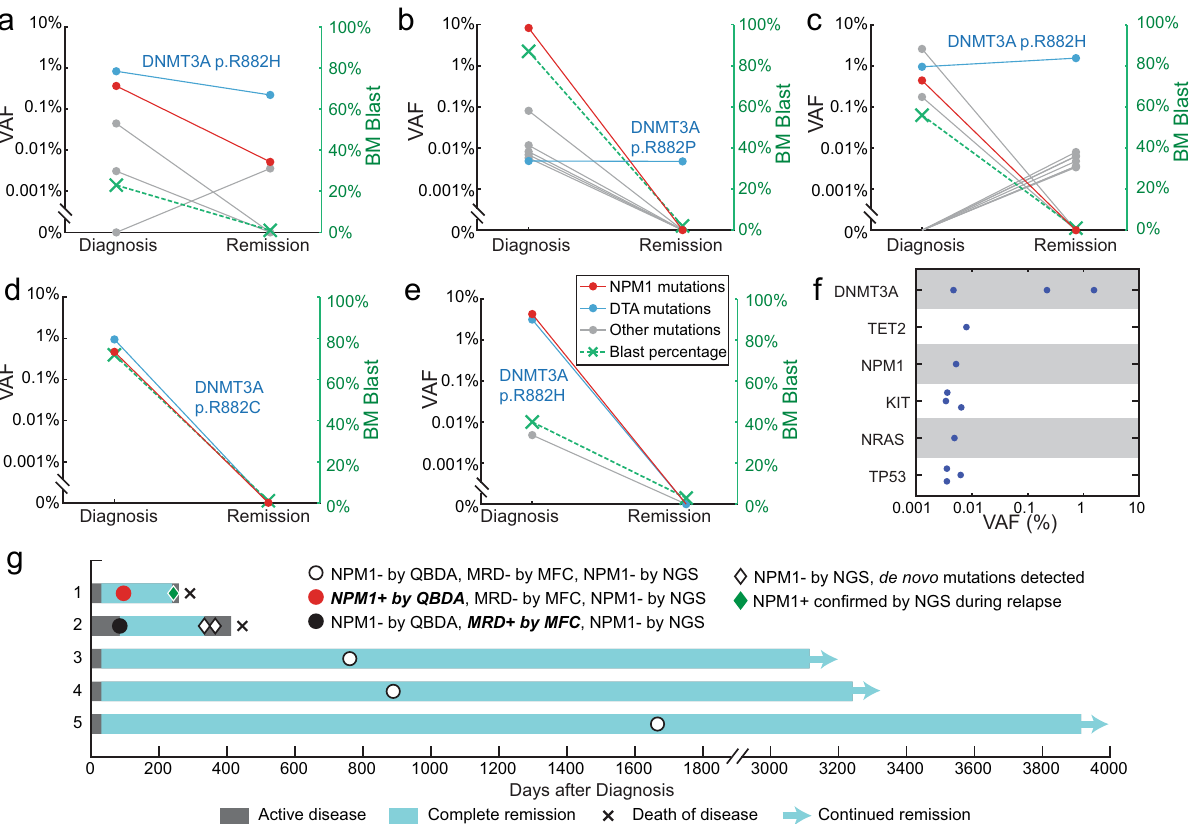
Fig. 3 QBDA for mutation detection during AML complete remission. a – e Changes of mutation VAF and the percentage of blasts in bone marrow from diagnosis to complete remission for each of the fi ve patients. The mutations in NPM1 were highlighted in red and mutations in DTA (i.e., DNMT3A , TET2 , and ASXL1 ) were highlighted in blue. Other mutations were shown in gray. f Summary of mutations detected from fi ve patients during remission using the QBDA AML panel covering 22 hotspot regions in 20 genes. g Swimmer plot of clinical course and molecular fi ndings of patients. QBDA identi fi ed NPM1 mutation in patient 1 during remission while fl ow cytometry reported MRD negative and conventional NGS failed to detect NPM1 mutation at the same time point. This NPM1 mutation was observed by conventional NGS during relapse. QBDA did not observe NPM1 mutation in patient 2 while MRD positive is reported by fl ow cytometry. In the two subsequent time points even after relapse NMP1 mutation was still not observed. Instead, de novo mutations in KDM6A and PHF6 were identi fi ed indicating clonal evolution occurred as alternative cause of